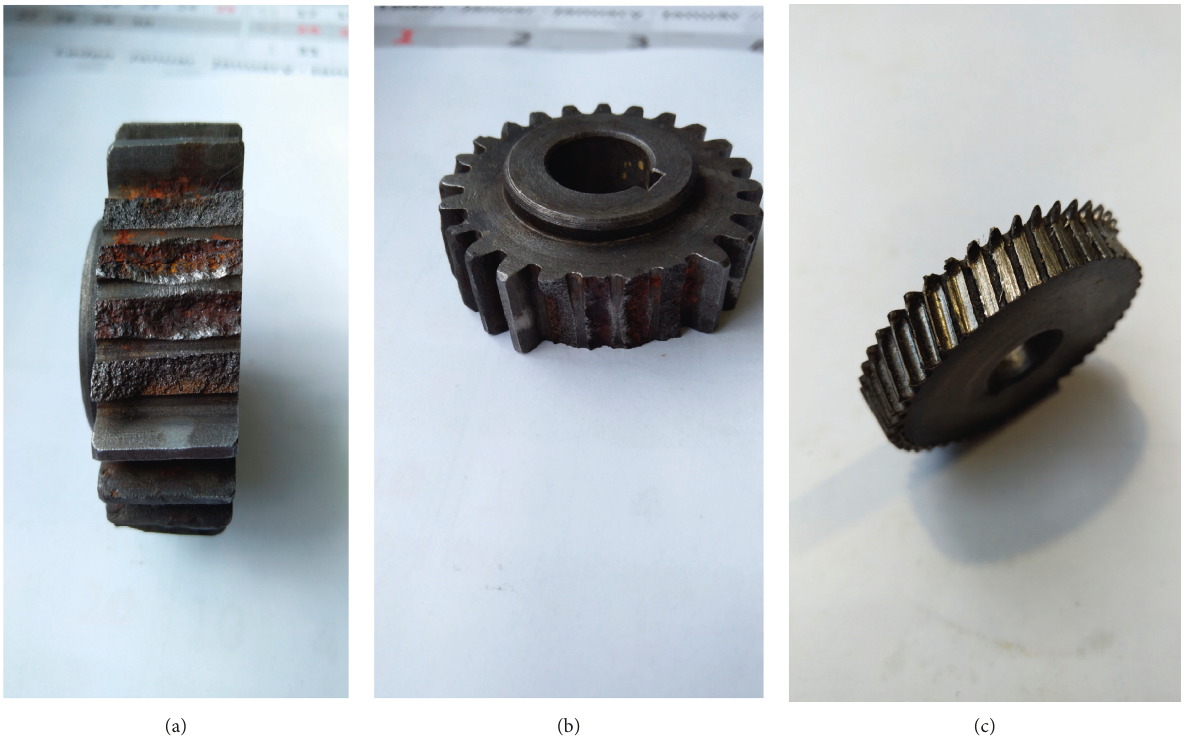
Figure 1: Demonstration of gear toothing damage.